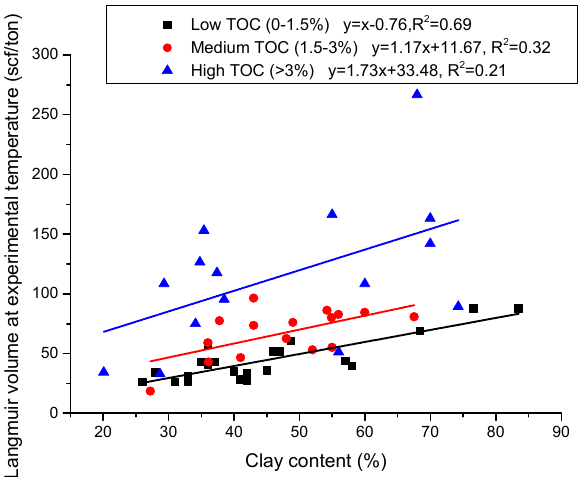
Figure 3. The relationship between the clay content and Langmuir volume at experimental temperature for low, medium and high TOC shale samples.